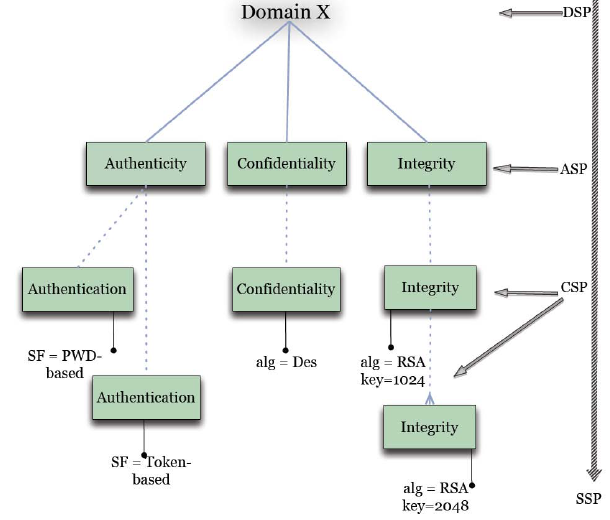
Figure 2. An example of a hierarchy of security properties for Domain X.